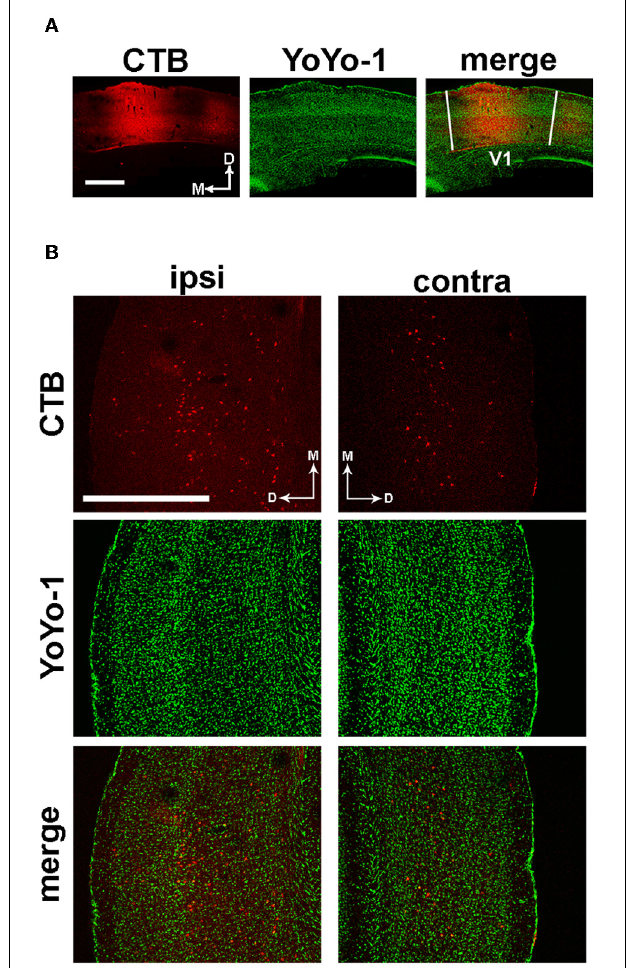
FIGURE 1 | Identification of anatomical projections from A1 to V1. (A) Representative image of the CTB injection site and YoYo-1 nuclear counterstaining, which remained confined within the boundaries of V1. (B) Left; immunofluorescence images showing retrograde transport of CTB injected in V1 to ipsilateral layers IV-VI of the primary auditory cortex (red), with a few scattered somata in layer II-III. Right; in the hemisphere contralateral to the injection site, a few cells are labeled in layers V–VI. Nuclei are counterstained with YoYo-1 (green). Scale bar is 500 μ